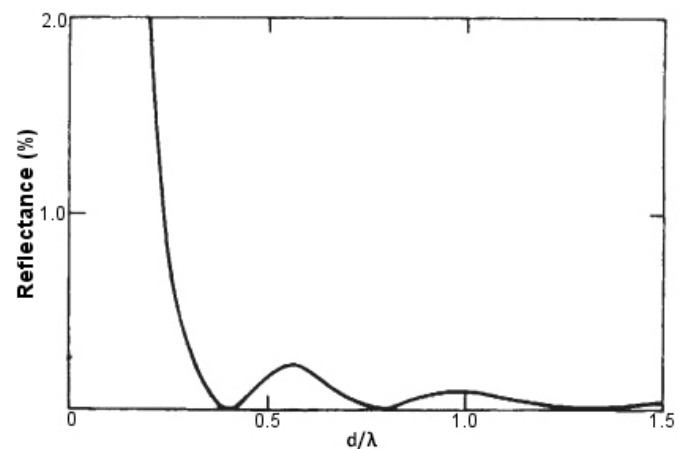
Figure 13. Computed dependence of the reflectance levels in fabricated moth eye-like structures on the ratio of the height of conical protuberances with the incident wavelength of light ( d / λ ). Adapted with permission from Macmillan Publishers Ltd: Nature [64], copyright